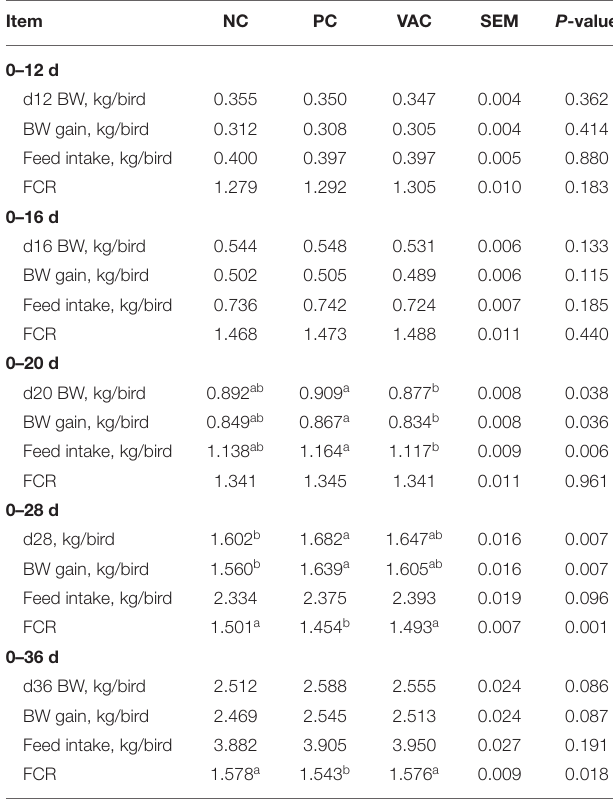
TABLE 2 | Effects of coccidiosis vaccination on plasma carotenoid and nitric oxide concentrations from 12 to 36 d post-hatch 1,2 . Item